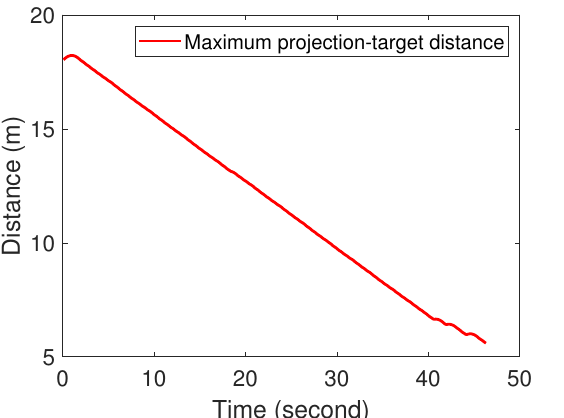
Figure 6. The convergence of the maximum projection-target distance corresponding to the simulation in Figure 5.